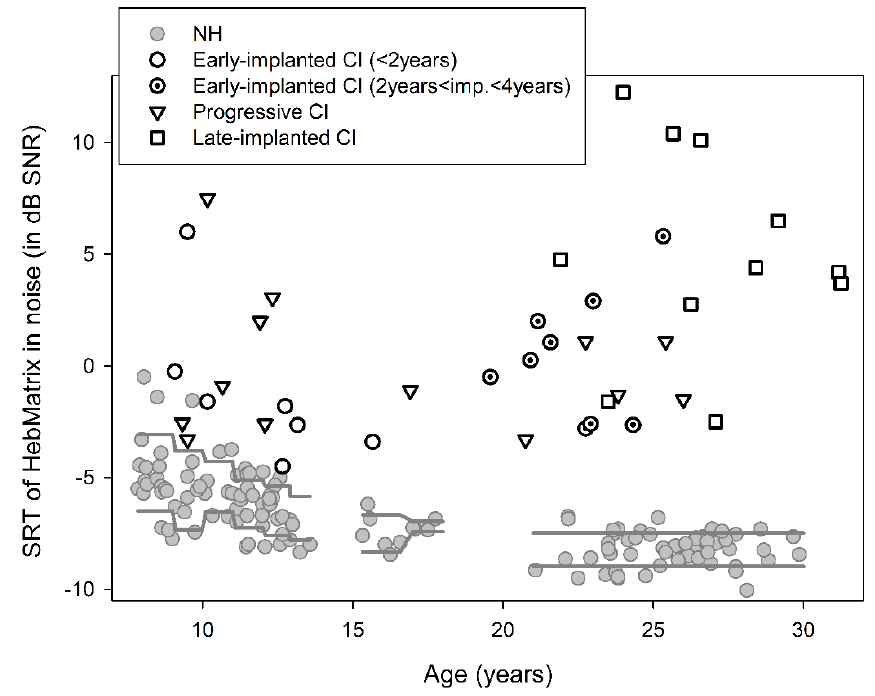
Figure 1. Individual speech reception thresholds in noise (SRTn) of the Hebrew Matrix sentence-in-noise test (mean signal-to-noise ratio (SNR) in measurements 3, 4) for early-implanted cochlear implants (CI) users ( n = 16, seven implanted before two years of age), progressive CI users ( n = 13), late-implanted CI users ( n = 11), and normal hearing (NH) controls ( n = 136). Mean performance of the NH ± 1 standard deviation is shown between the gray lines.